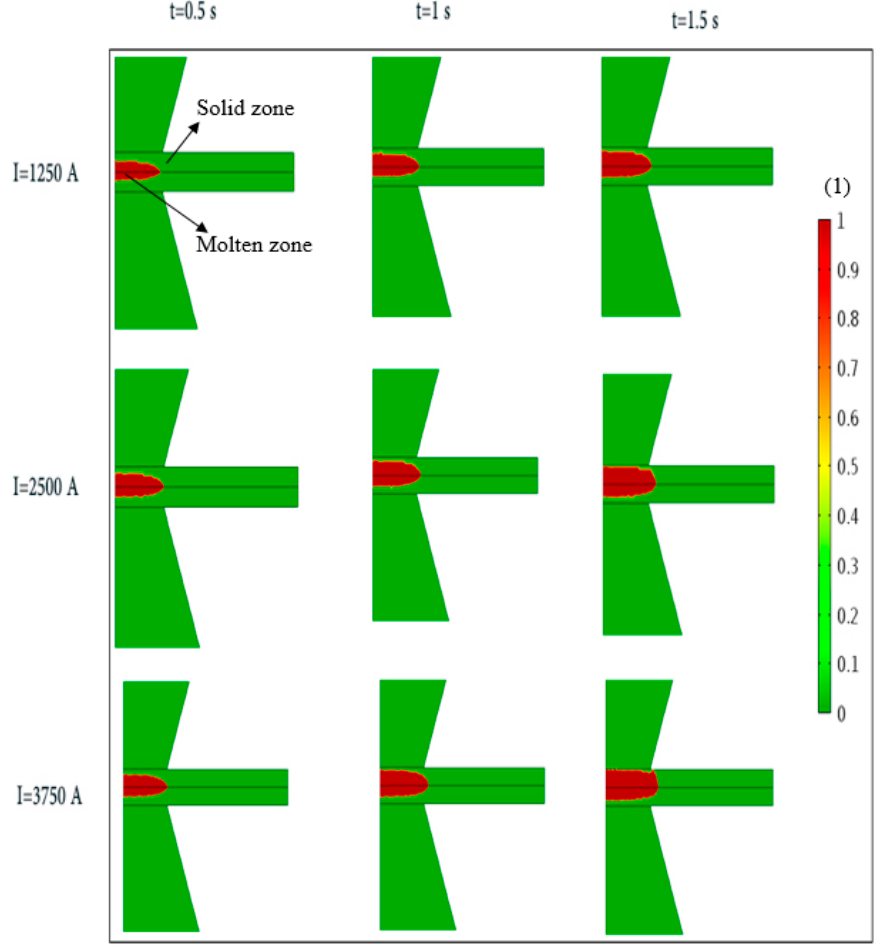
Figure 7. Simulation results of welding nugget size in the joint area during welding.